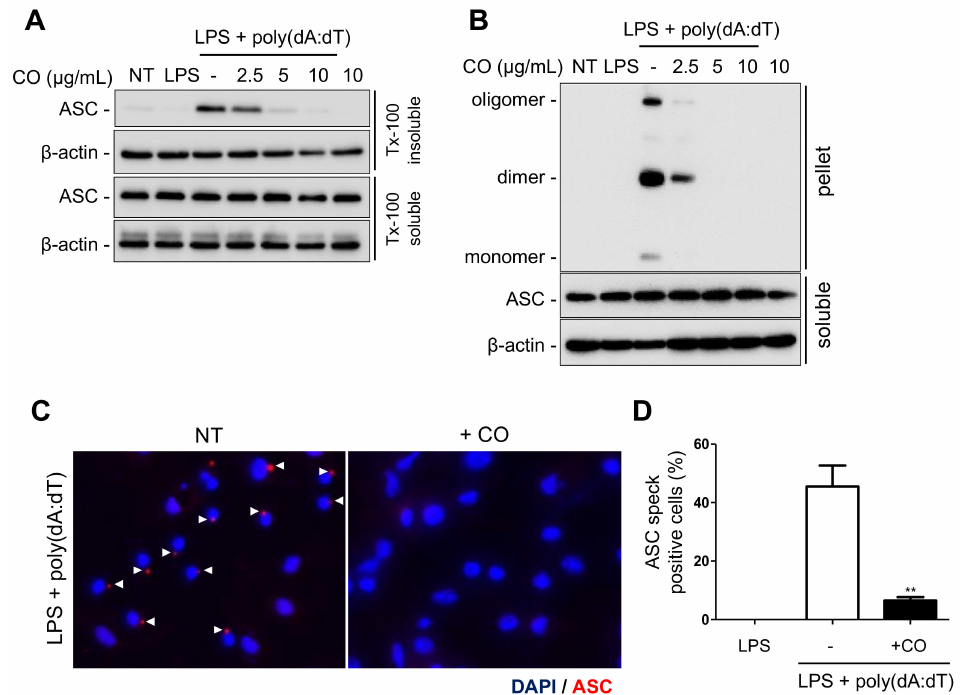
Figure 4. CO inhibits ASC speck formation during AIM2 inflammasome activation. ( A – D ) LPS (100 ng/mL)-primed BMDMs were pre-treated with CO for 30 min, then transfected with poly(dA:dT) (1 µ g/mL) for 2 h. Western blots of ( A ) ASC translocation from Triton X-100 soluble fraction to insoluble fraction, ( B ) ASC oligomerization in the insoluble fraction (pellet), and ( C ) ASC speck images at 400 × magnification upon stimulation with poly(dA:dT). ASC and nuclei are depicted in red and blue (DAPI), respectively. White arrowheads point to ASC speck. ( D ) Quantification of cells with ASC specks showed the percentage of positive cells. At least three fields and more than 100 cells were counted for each condition. Data represent the means ± SDs of three independent experiments; ** p <